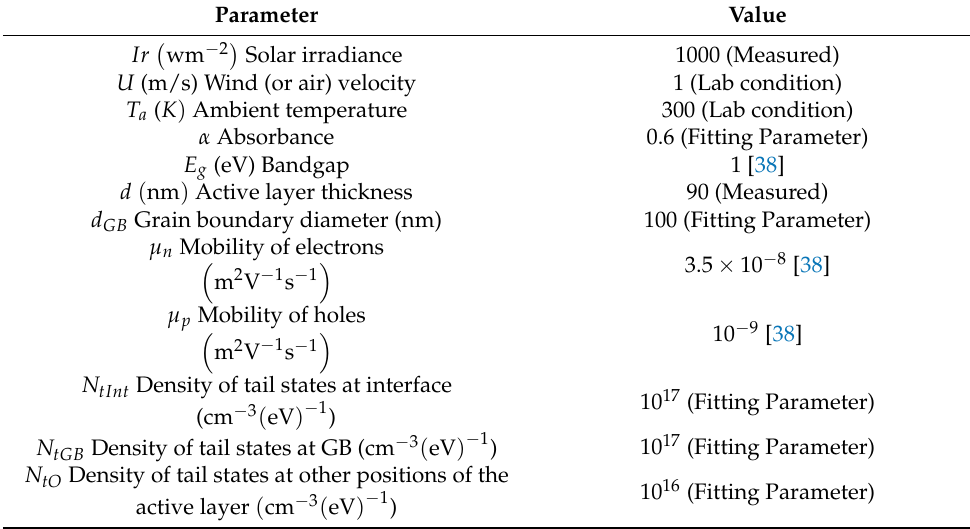
Figure 4. Comparison between the measured and simulated 𝐽 - 𝑉 characteristics of the OSC of the structure: ITO/PEDOT:PSS (40 nm)/P3HT:PCBM (90nm)/ZnO (10 nm)/Ag (100 nm). Table 1. List of input parameters used for simulation in this paper.